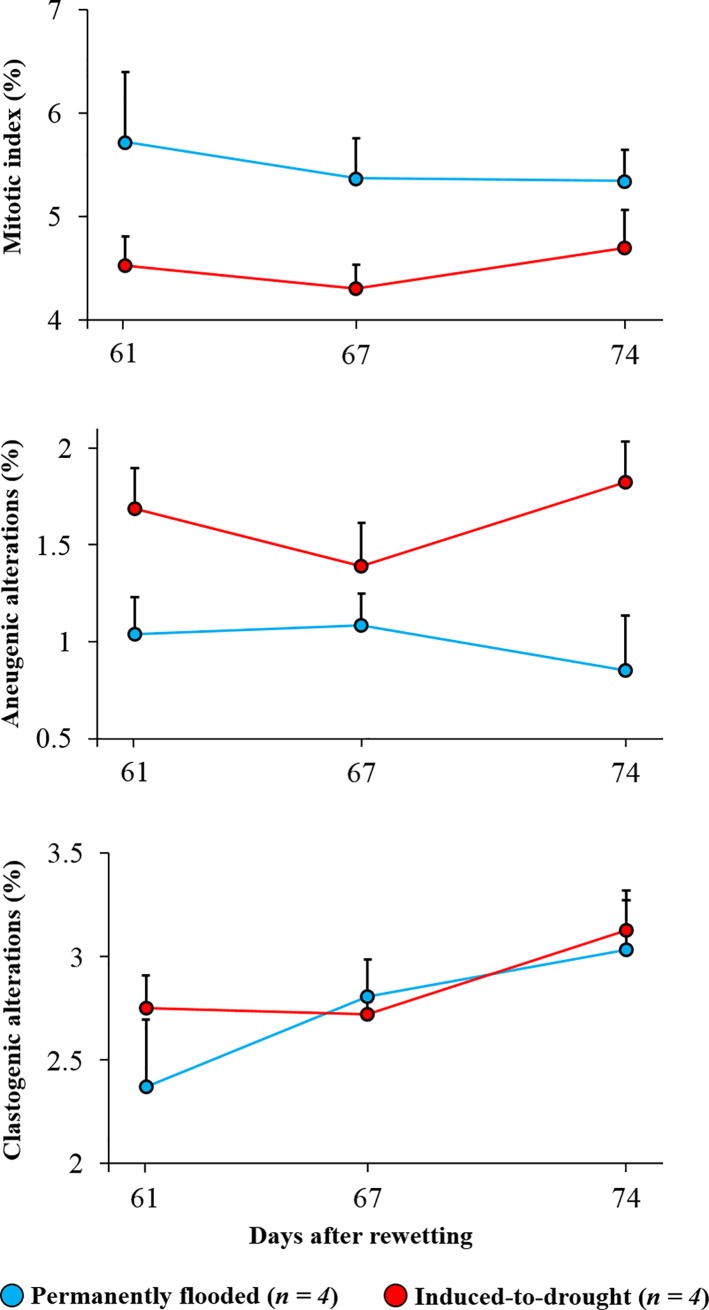
Average ± standard deviation of mitotic index, and aneugenic and clastogenic alterations from Allium cepa tests between groups (permanently flooded: blue, and induced-to-drought: red) on different sampling days during the rewetting period.For a better view of results, only the upper standard deviation is shown.